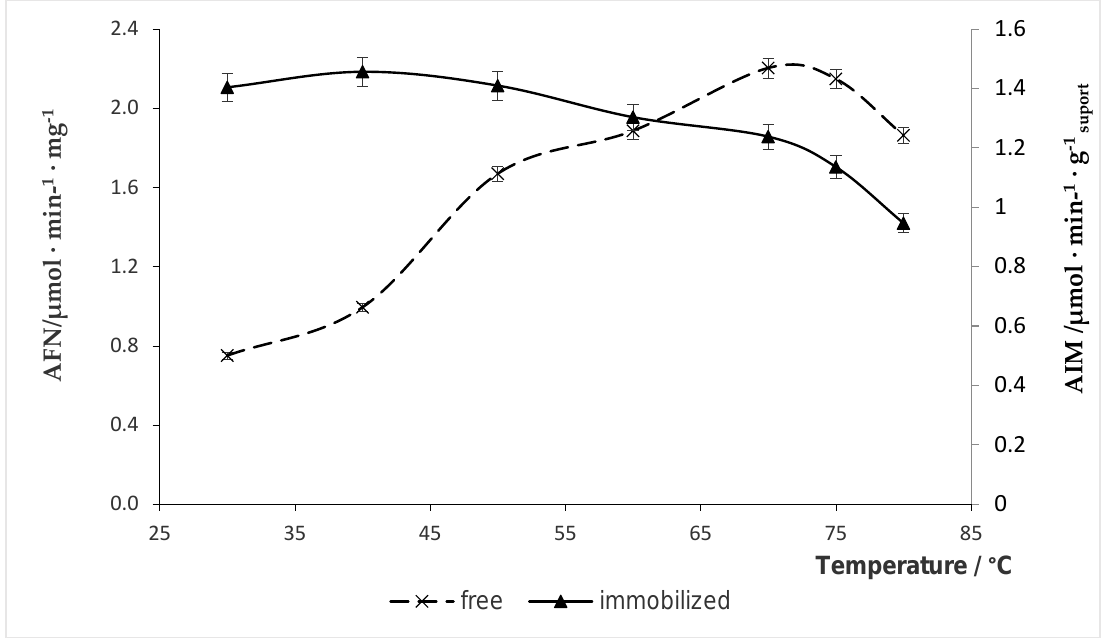
Figure 3. Effect of temperature on activity of free and immobilized naringinase. AFN—activity of free naringinase; AIM—activity of immobilized naringinase.